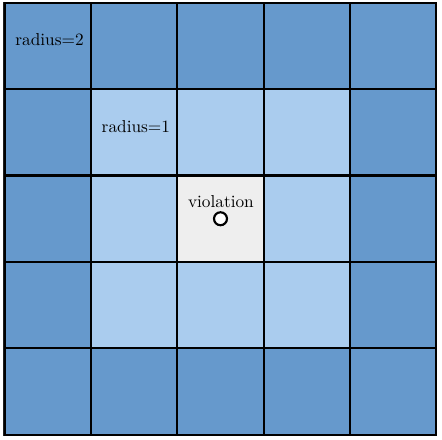
Fig. 1. Illustration of the ILMC filter in two dimensions. The ring in the center indicates the cell containing a shape preserving violation. The coloured squares are the cells included in the first (light blue) and second (dark blue) iteration, respectively. In three dimensions the coloured rings become shells consisting of cells in the layers above and below as well.